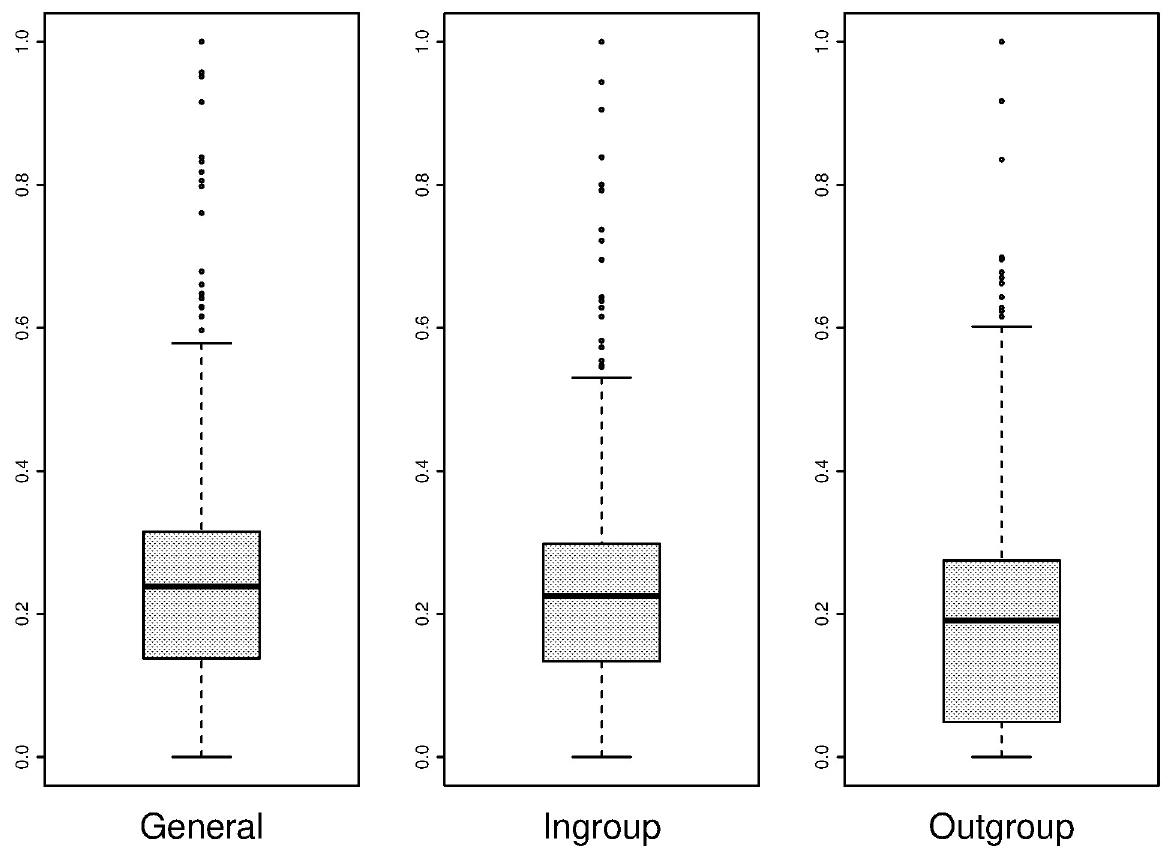
Fig 7. Trustworthiness of players towards general (left), ingroup (centre) and outgroup (right) players as displayed in the IG.